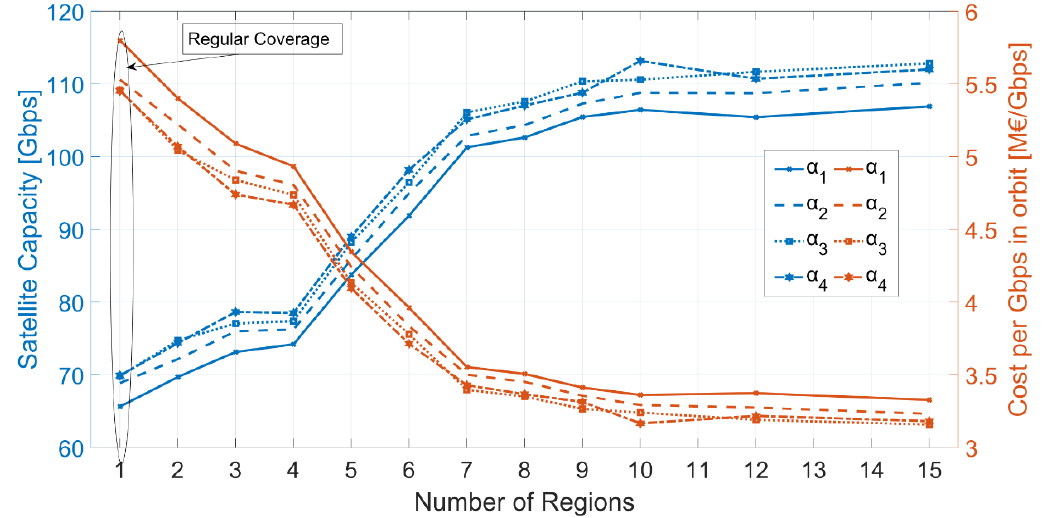
Figure 13. Performance based on the number of regions into which the service area is divided and grid orientation: Satellite Capacity and Cost per Gbps in orbit.